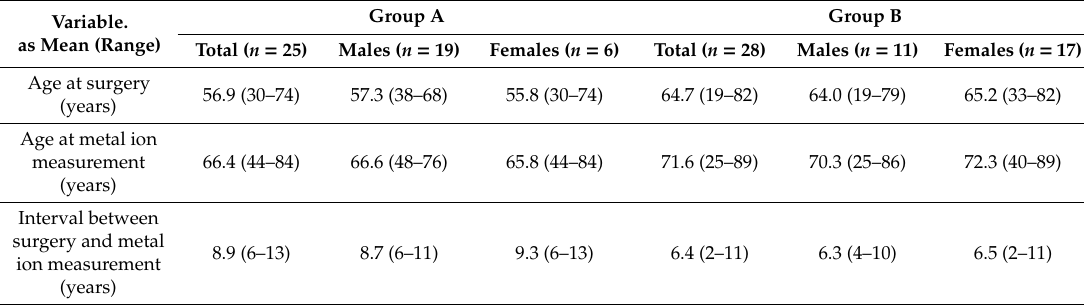
Table 1. Characteristics of the